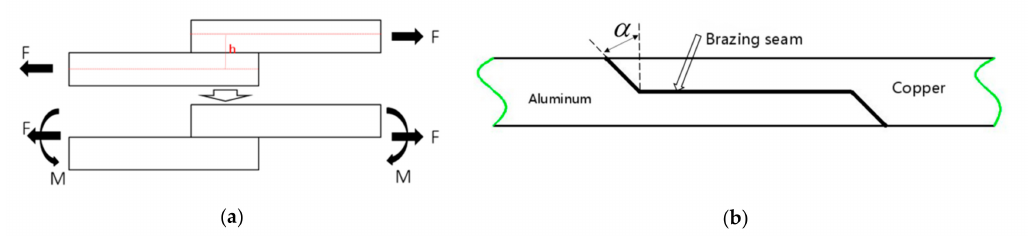
Figure 1. Traditional lap joint and improved lap joint. ( a ) Lap joint with addition bending moments. ( b ) Improved lap joint.